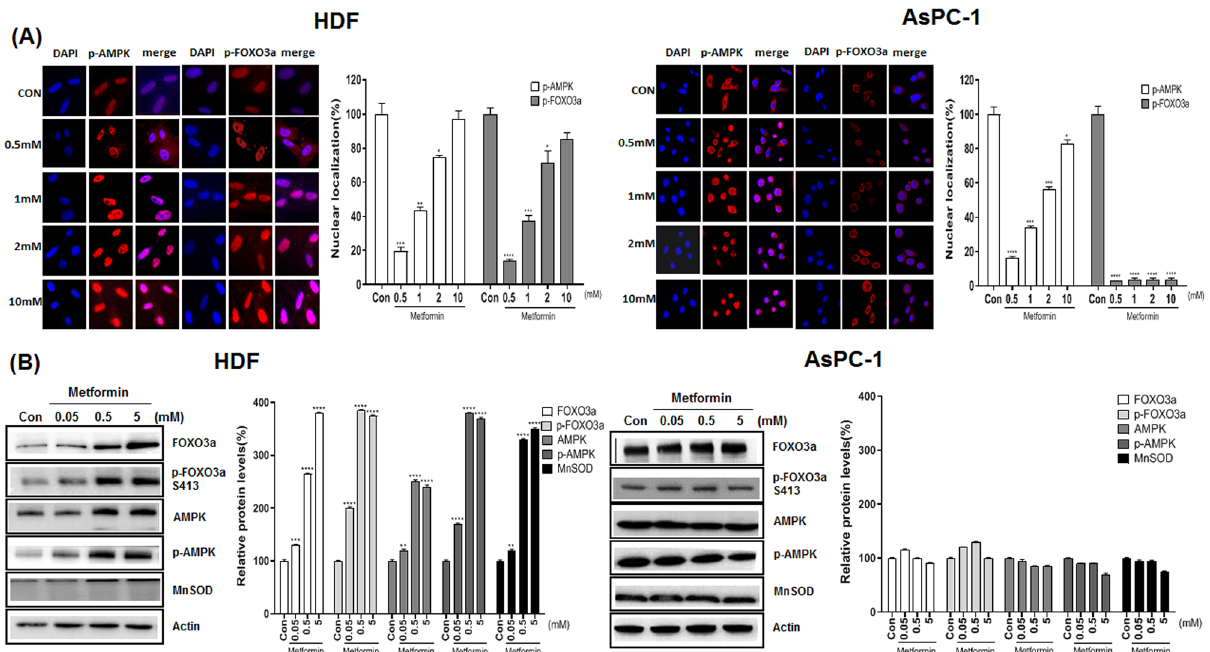
Figure 2. Nuclear localization and protein levels of p-AMPK (Thr172) and p-FOXO3a (Ser413) in metformin- treated AsPC-1 and HDF cells. AsPC-1 and HDF cells were treated with metformin (0.05, 0.5, 5 mM) for 24 h. ( A ) Immunostaining was performed in AsPC-1 and HDF cells using anti-p-AMPK (Thr172) and p-FOXO3a (Ser413) antibodies. Anti-mouse IgG, F(ab’)2 fragment (Alexa fluor 594 conjugate, red color) was used as the secondary antibody. DAPI (blue color) was used as the nucleus marker. ( B ) Levels of AMPK, p-AMPK (Thr172), FOXO3a, p-FOXO3a (Ser413) and MnSOD proteins were measured in metformin-treated AsPC-1 and HDF cells by western blot analysis. Three different measurements were performed for each sample. Statistical significance is indicated as * p < 0.05, ** p < 0.01, ***p < 0.001, and **** p < 0.0001 compared with control